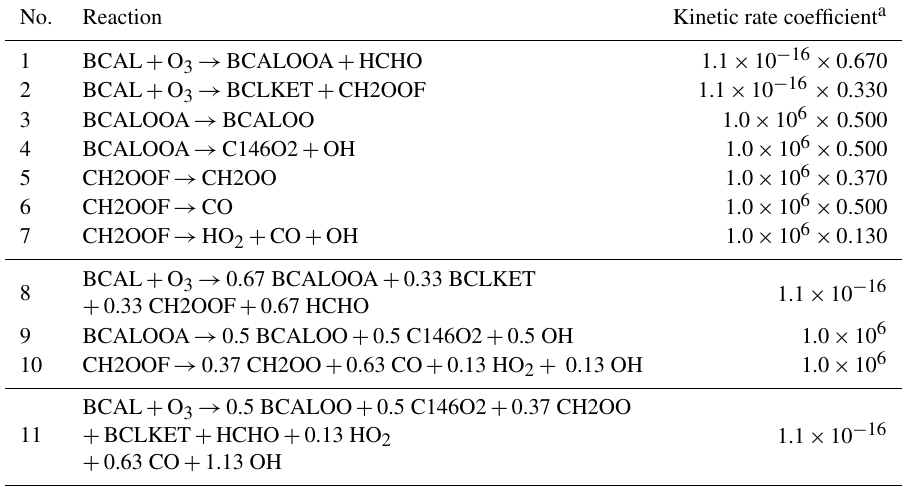
Table 1. Reactions before and after prereduction, where the MCM (v3.3.1) species BCALOOA and CH2OOF are skipped over by their degradation products. The molecular structures of all mentioned MCM species can be found in Fig.